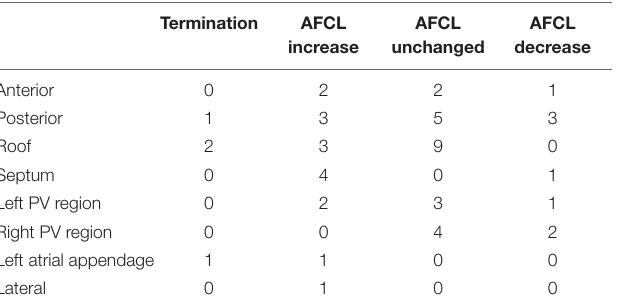
TABLE 2 | Location of ablated regions targeted using HDF mapping, and their associated left atrial